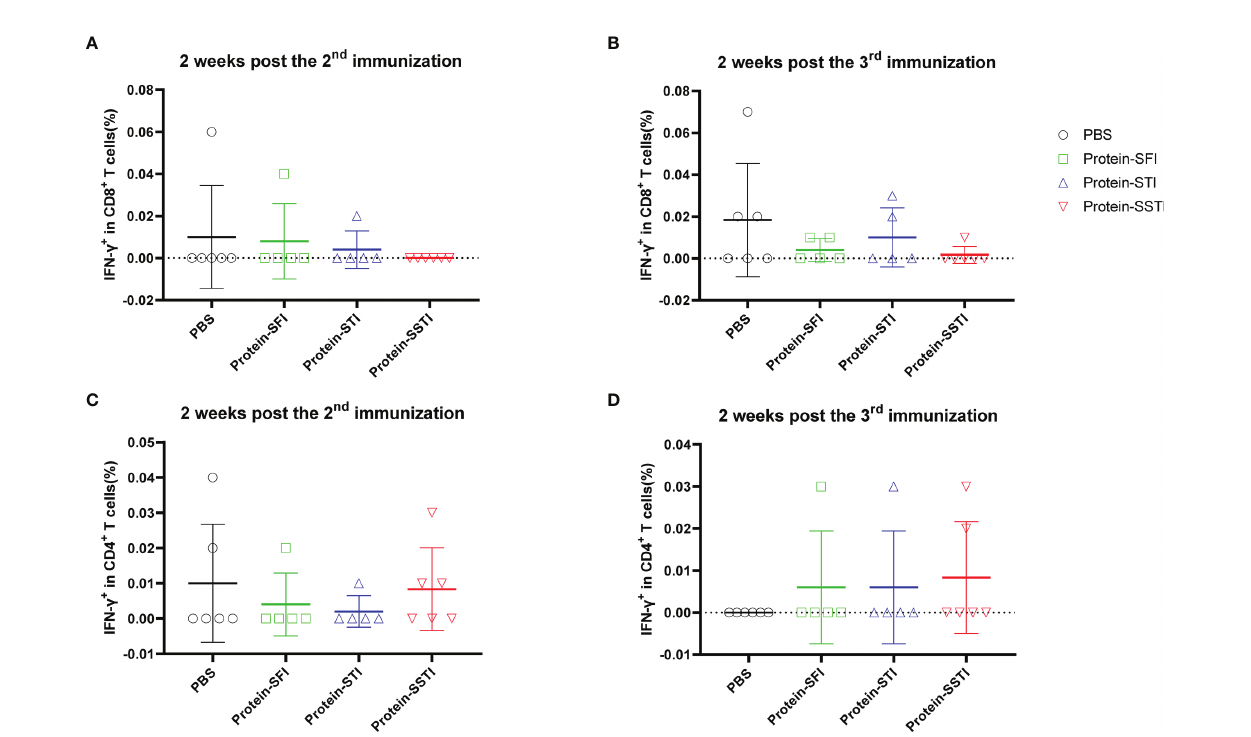
FIGURE 4 | Frequencies of circulating S protein speci fi c IFN- g secreting CD8 + T cells elicited by the protein subunit vaccine at 2 weeks post the 2 nd and 3 rd immunization. Peripheral blood were collected from mice immunized with the DNA vaccine at 2 weeks post the 2 nd and 3 rd immunization. S protein speci fi c IFN- g secreting CD8 + T cells (A, B) and CD4 + T cells (C, D) in peripheral blood were detected by intracellular cytokine staining (ICS). Data are shown as mean ± SD. Statistical analyses were performed using the method of